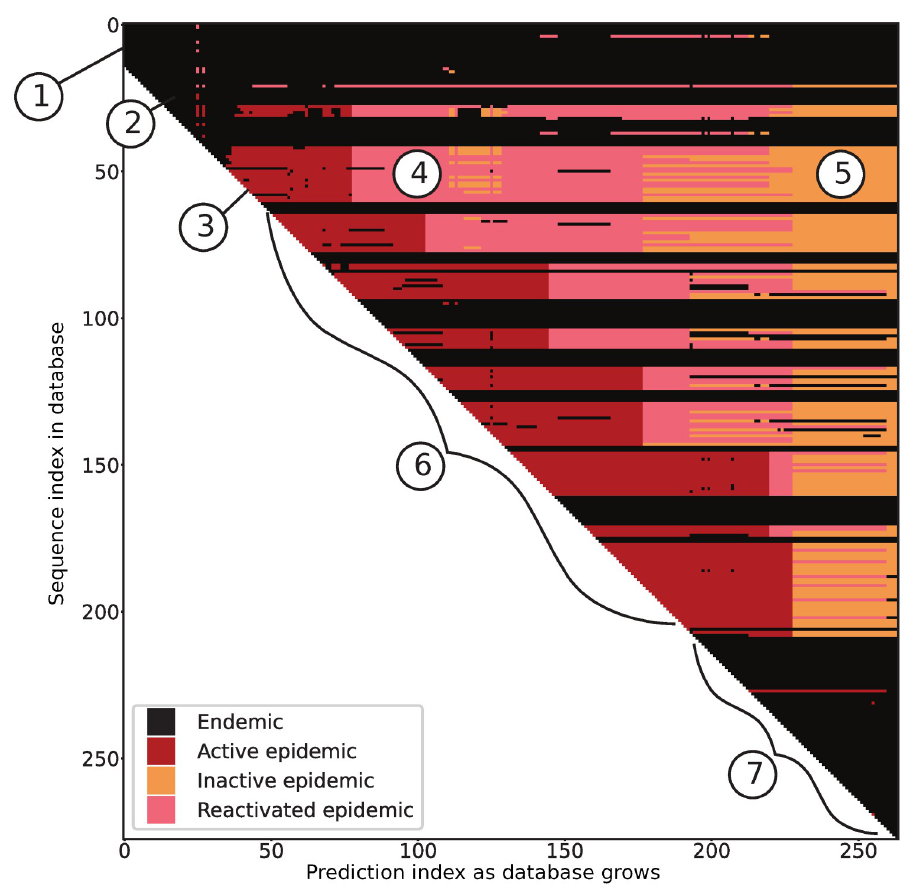
Fig 7. Real-time detection of a HIV-1 CRF01 outbreak (see Fig 3 for methodology). As sequences are added to a growing database (from top to bottom on the y-axis) and time progresses (x-axis), one distance matrix is analyzed at each sequence addition and an updated classification of all current sequences is added as a slice along the x-axis. Our model classifies each infection as belonging to an outbreak (epidemic) or as endemic. The epidemic label is refined into active, inactive, or reactivated based on the time since detection. Here, the transition cutoff from active epidemic to inactive/reactivated epidemic is 2 years. Circled numbers indicate events of interest, discussed in the main text.